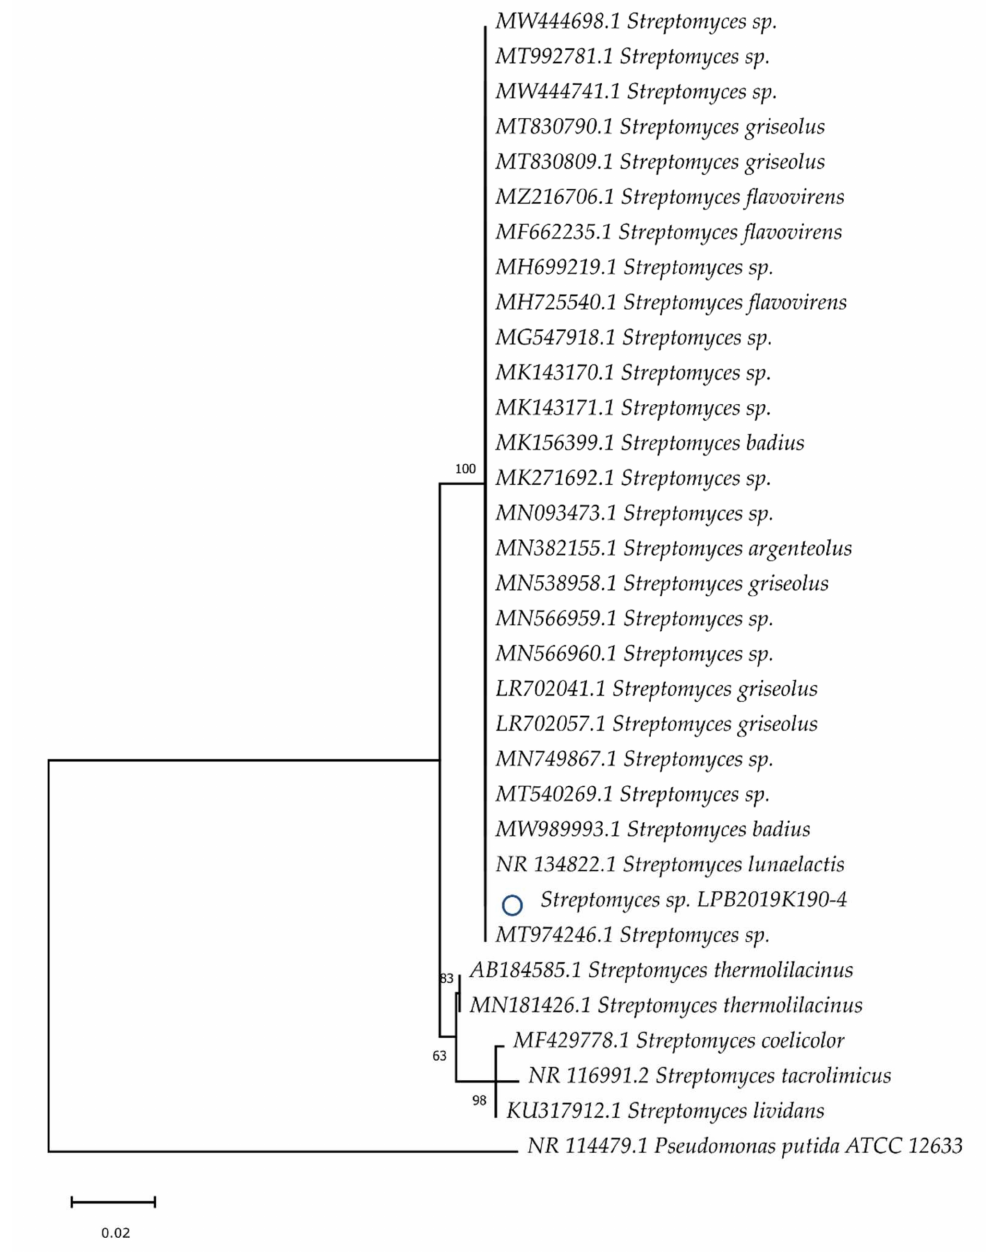
Figure 3. Evolutionary relationships of the Baikal strain of Streptomyces sp. The phylogenetic tree was constructed using the Neighbor-Joining method. The Baikal strain is marked with the “o”